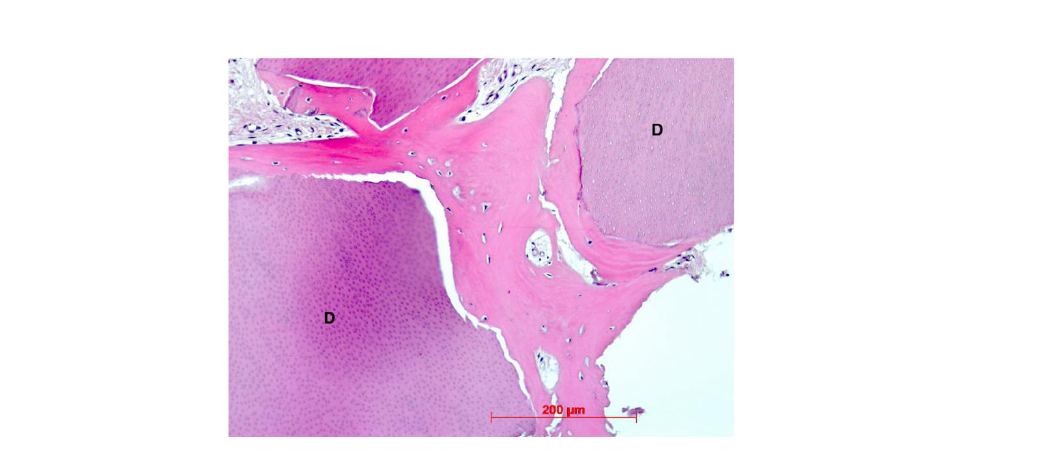
Figure 12. Patient 6—Perigranular osteogenesis between dentin granules (D), HE, original magnification × 20.